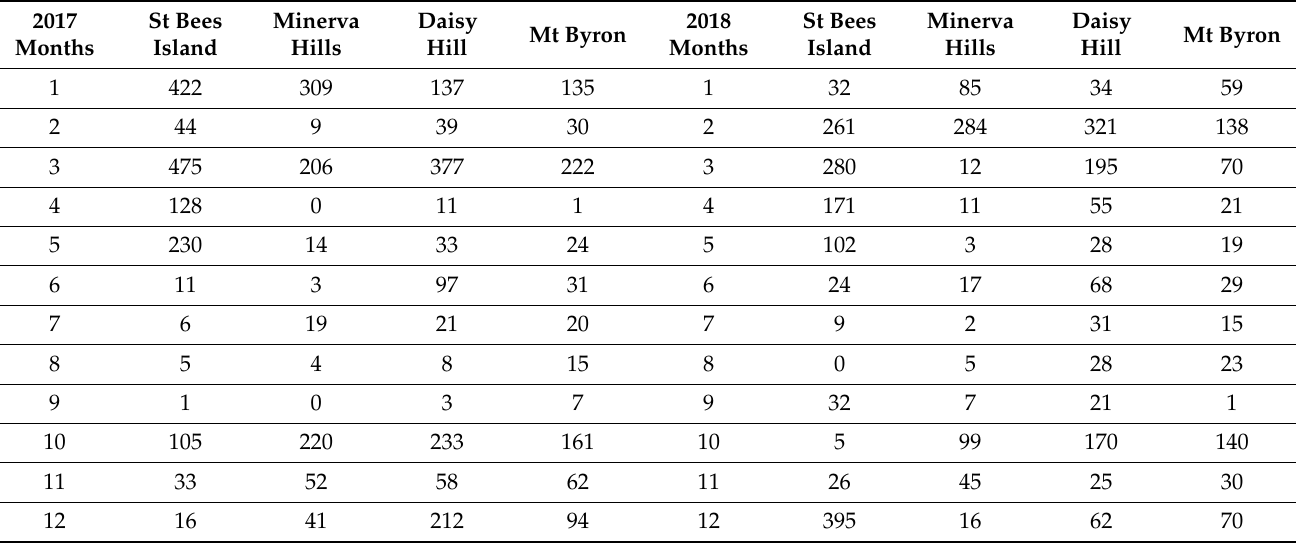
Table A4. Monthly accumulated rainfall in mm for the four field sites in 2017 and 2018. For St Bees Island, the rain gauge at Hamilton Island is used, and for Mt. Byron, the Toogoolawah rain